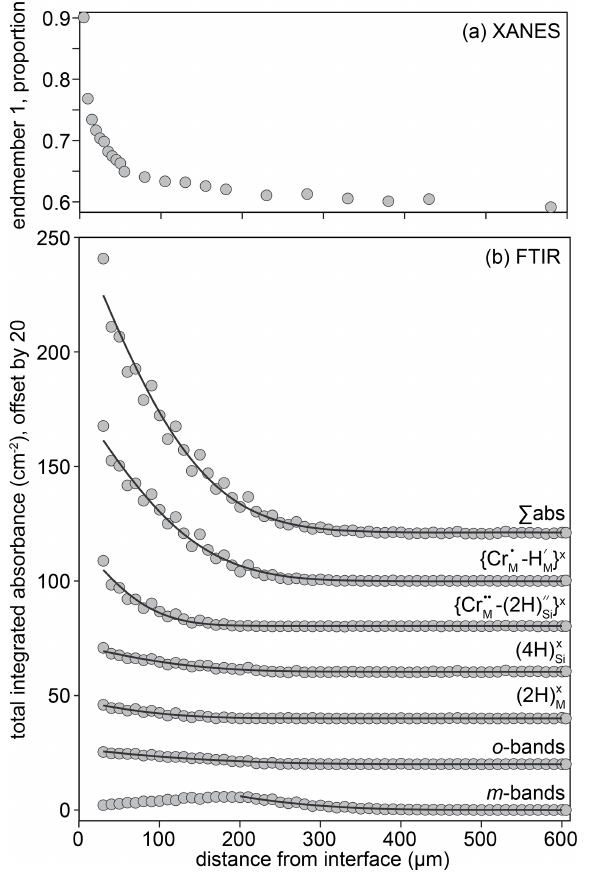
Figure 7. Profiles obtained from XANES and FTIR spectra of the same sample (as shown in Fig. 5, HYCRa3, 850 ◦ C, Ni–NiO, 1.5GPa, enstatite buffer, 43200s). (a) The proportion of end- member 1 determined by linear combination fitting of the XANES spectra (see Fig. 9 for examples of linear combination fitting). (b) The intensity of FTIR peaks corresponding to different defects, as well as sum of absorbance ( (cid:80) abs), offset for clarity. Fits to Eq. (2) are shown by the solid lines. All points < 200µm from the interface were not included in the “ m -bands” fit. Uncertainties as- sociated with peak fitting are smaller than the